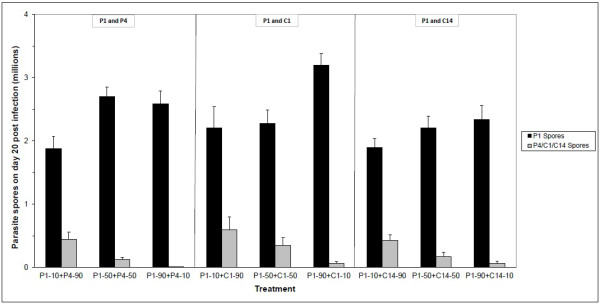
Parasite spore production on day 20 post-infection in mixed infections. Parasite spore production on day 20 post-infection by parasite isolates/clones P1 and P4 (left panel), P1 and C1 (middle panel), and P1 and C14 (right panel). Error bars are standard errors.